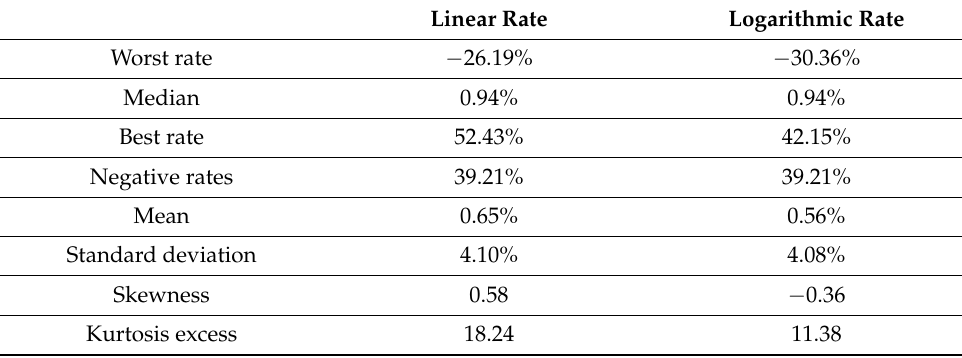
Table 1. Monthly real rates of return, 1872–2020. Linear Rate Logarithmic Rate Worst rate −